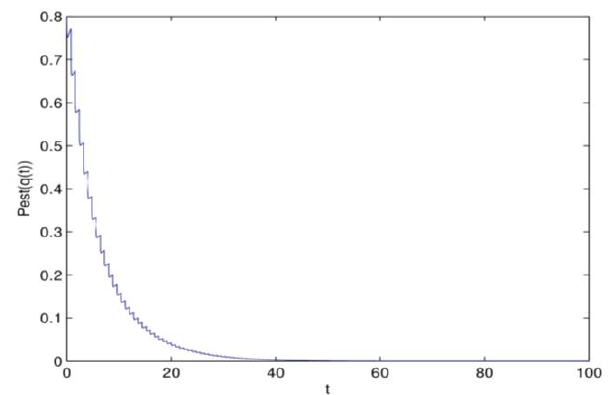
Figure 3. Pest population (𝑞(𝑡)) vanishes